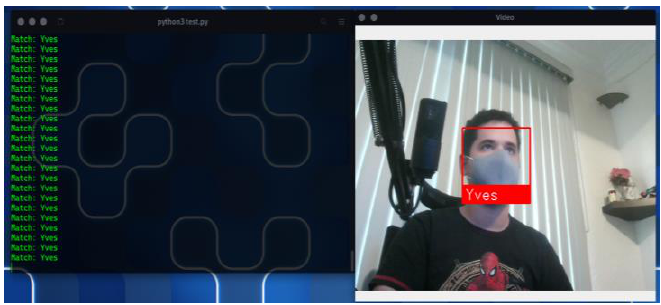
Figure 4: Example of Face Recognition.